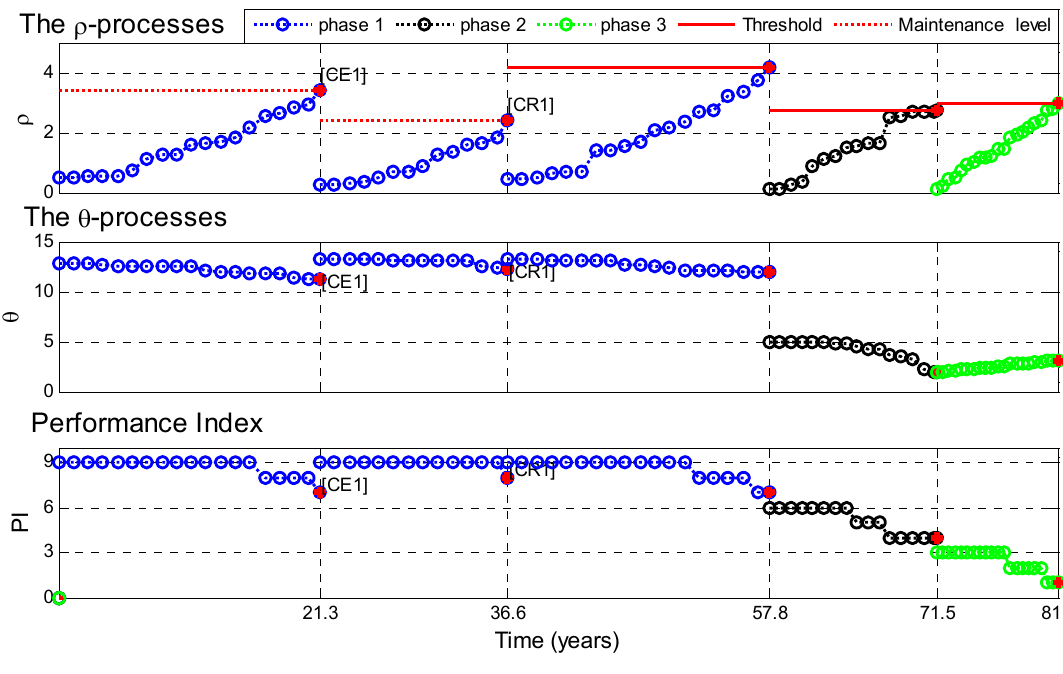
Figure 6. One realisation of S1.